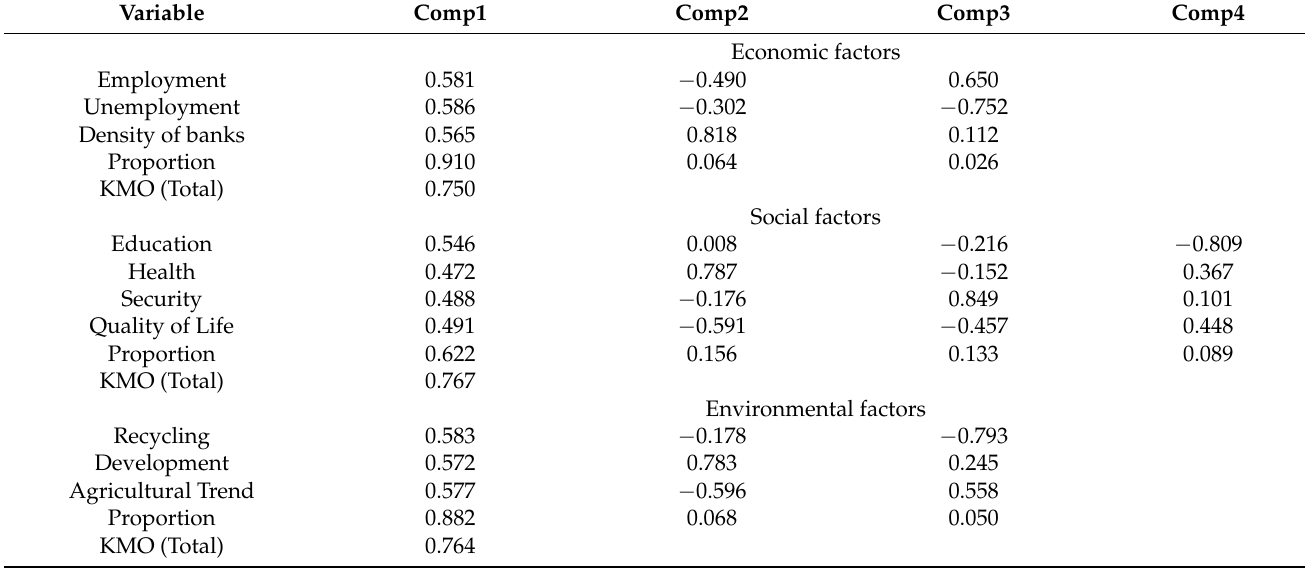
Table A2. Summarised factor analysis